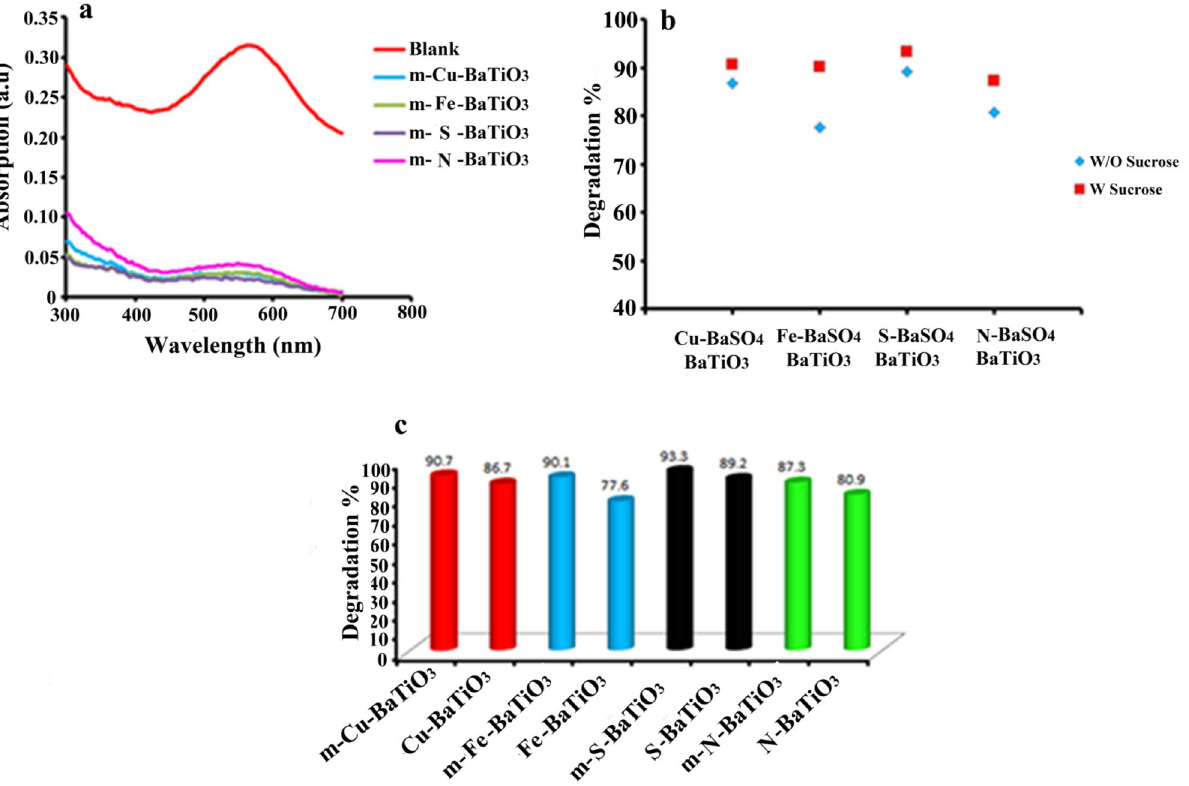
Figure 11. Effect of sucrose on piezocatalytic activity of doped BaTiO 3 to degrade AB113. ( A ) related UV–Vis spectra, ( b ) compare degradation for sucrose and without sucrose, and ( c ) related degradation efficiency with sucrose.